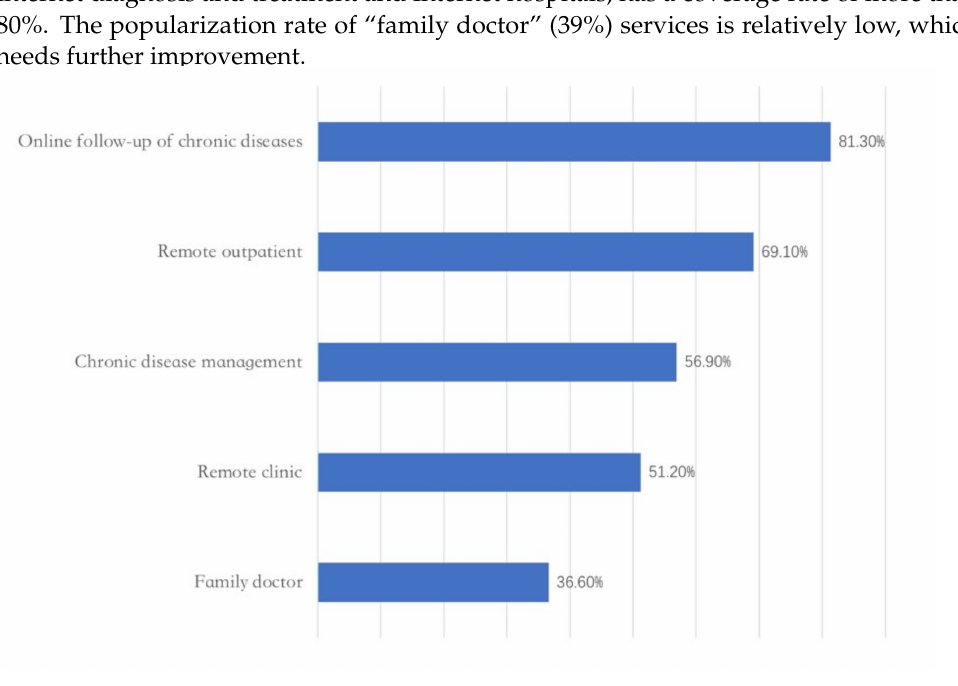
Figure 4. Core medical businesses. Adapted from source: National Telemedicine Center of China